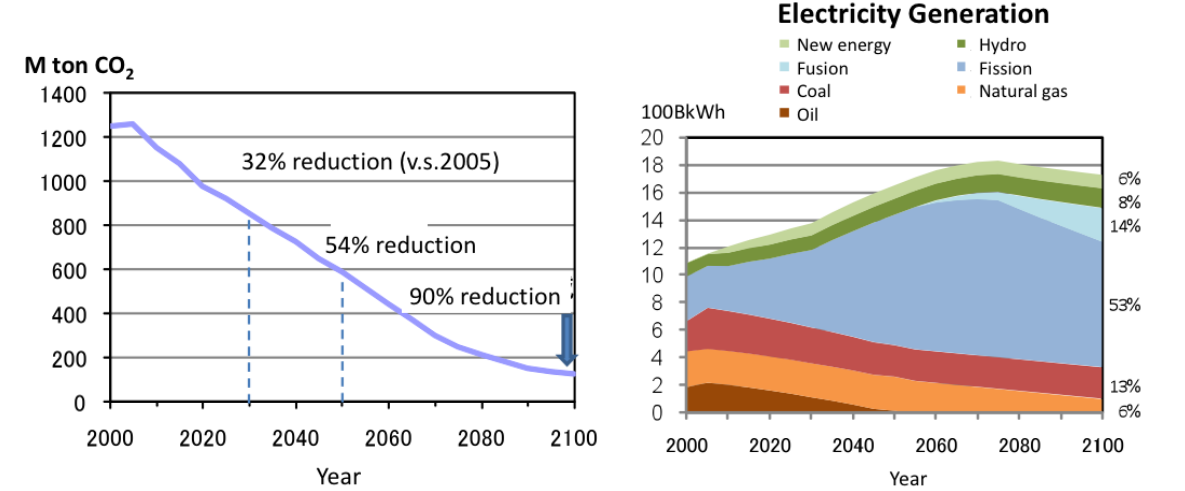
Figure 34. CO reduction scenario (left) and Electricity supply scenario from various 2 sources (right) in Atomic Energy vision 2100